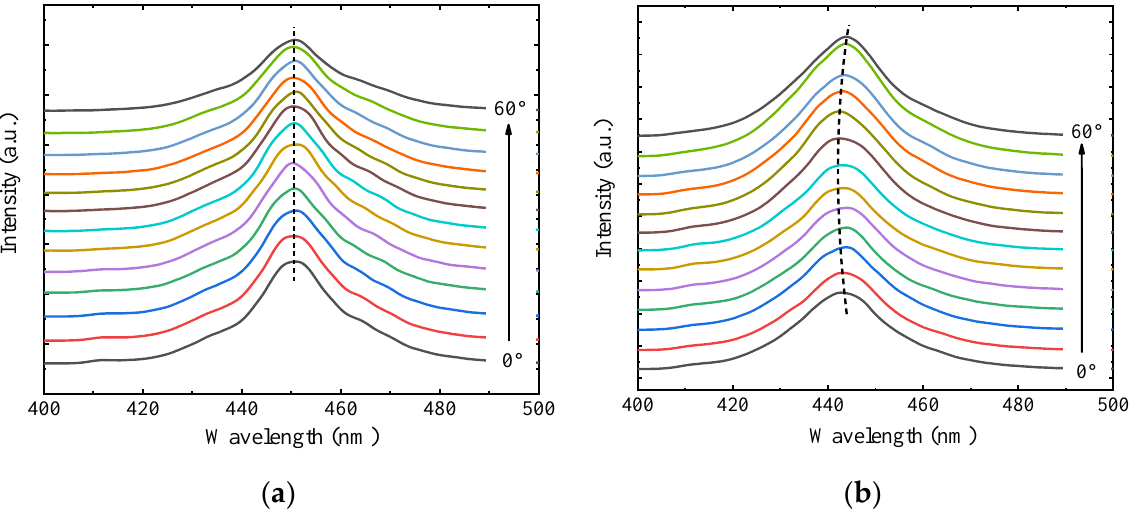
Figure 4. The AR - PL spectra of ( a ) flat area and ( b ) triangular-like ridge cavity. Figure 4. The AR-PL spectra of ( a ) flat area and ( b ) triangular-like ridge